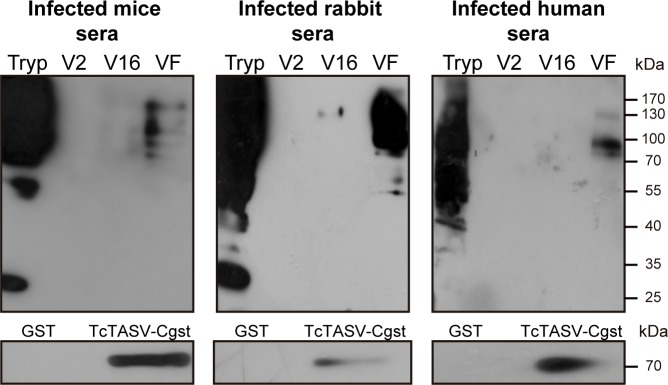
T. cruzi evades the immune system through the secretion of proteins into EVs.Western blot of CL Brener EVs probed with sera from Infected mice, rabbits and humans. The reactivity of these sera against rTcTASV-C is shown in the bottom panels. Tryp: trypomastigote; V2: large EVs; V16: small EVs; VF: vesicle-free fraction.